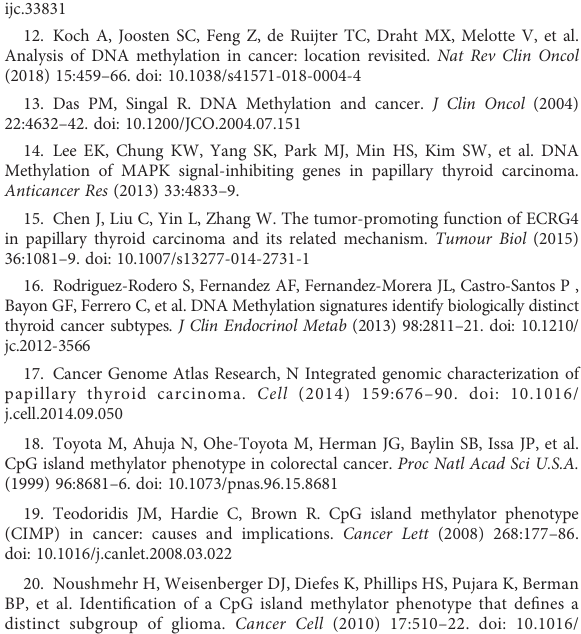
and clinicopathological features: (A) pTNM stage; (B) pT stage and (C) pN stage. SUPPLEMENTARY FIGURE 2 Scatter plot showing the generalized gene set testing (GGST) analysis between the the CIMP and nCIMP. The size of the dot represents the level of the differential expression (DE) of Hallmark pathways between the the CIMP and